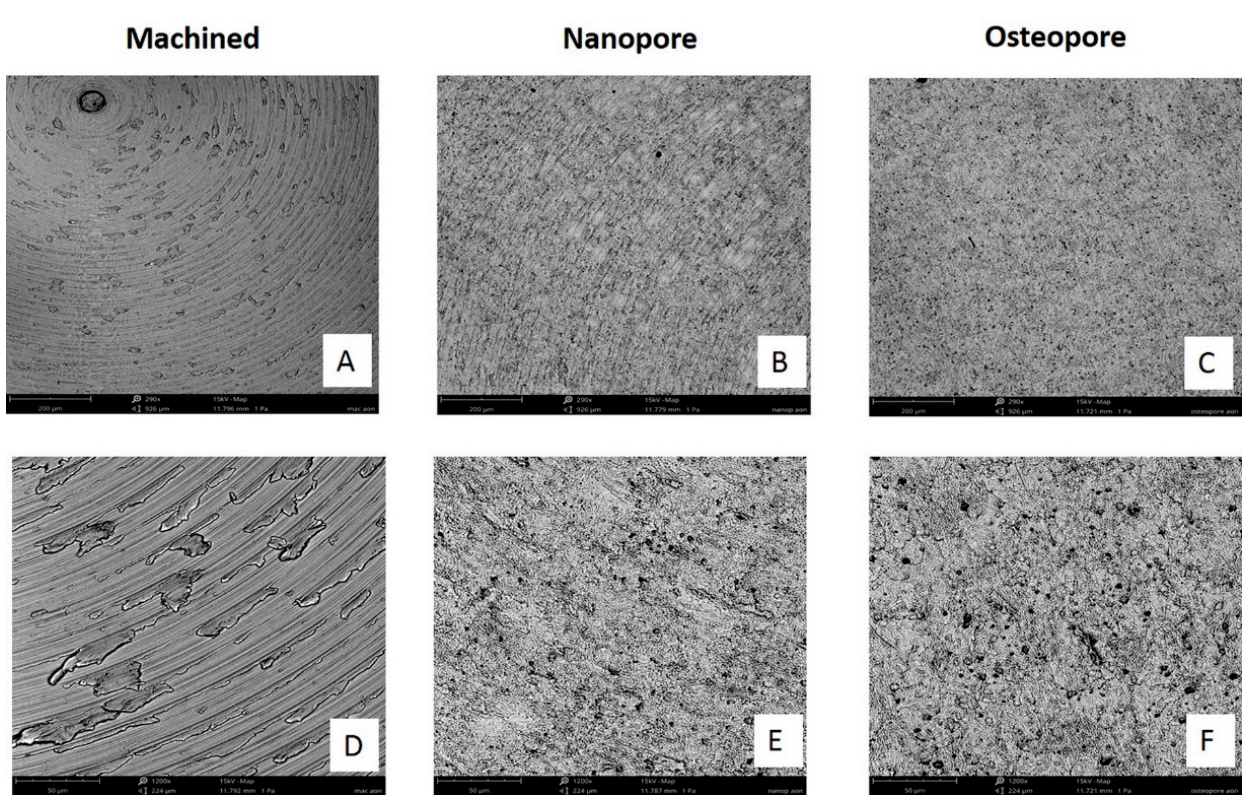
Figure 1. SEM observations of Ti discs. Topographic macro characteristics were evidenced at low magnification of 290× ( A – C ). Micro-topographic features of the discs were revealed at the magnifi- cation of 1200× ( D – F ). The CaP enrichment of nanopore surface did not change the topography at the micro level, because the original underlying metal microtopography was still preserved and could be easily identified ( E ). (Scale bar: 200 μ m at low magnification, 50 μ m at high magnification). From the sessile drop technique, all tested surfaces resulted hydrophilic with contact angles less than 90 ◦ (Figure 2A). The sessile drop method permitted the measurement of the water contact angle (WCA) of the different surfaces (Figure 2B): Machined (34.53 ◦ ), Nanopore (53.86 ◦ ), and Osteopore (63.60 ◦ ). The ANOVA test resulted p < 0.0001. Nanopore and Osteopore surfaces showed significantly larger contact angles than Machined (Ma- chined vs. Nanopore p = 0.0001; Machined vs. Osteopore p < 0.0001). Thus, the wettability was altered by double-etching and CaP